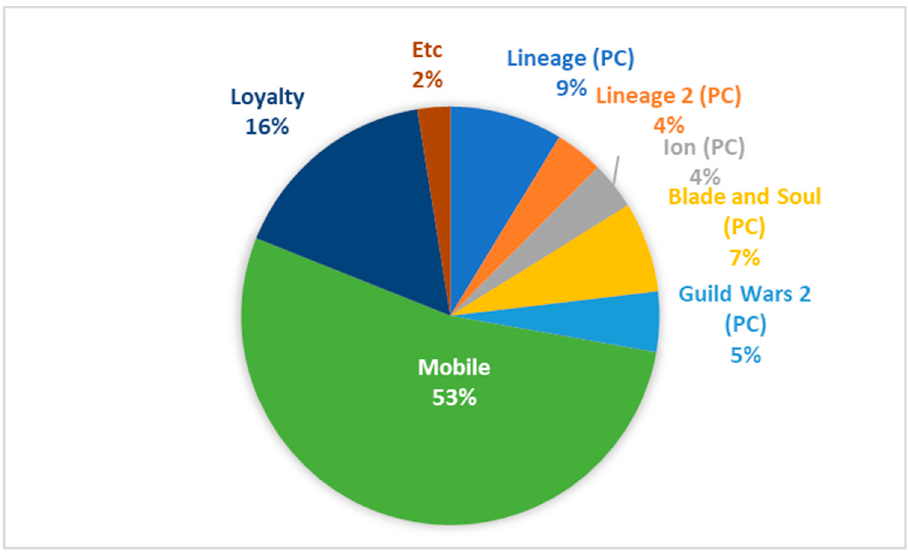
Figure 4. Sales Breakdown by Products (%) [19]. Graph created by the authors. Source: [19]